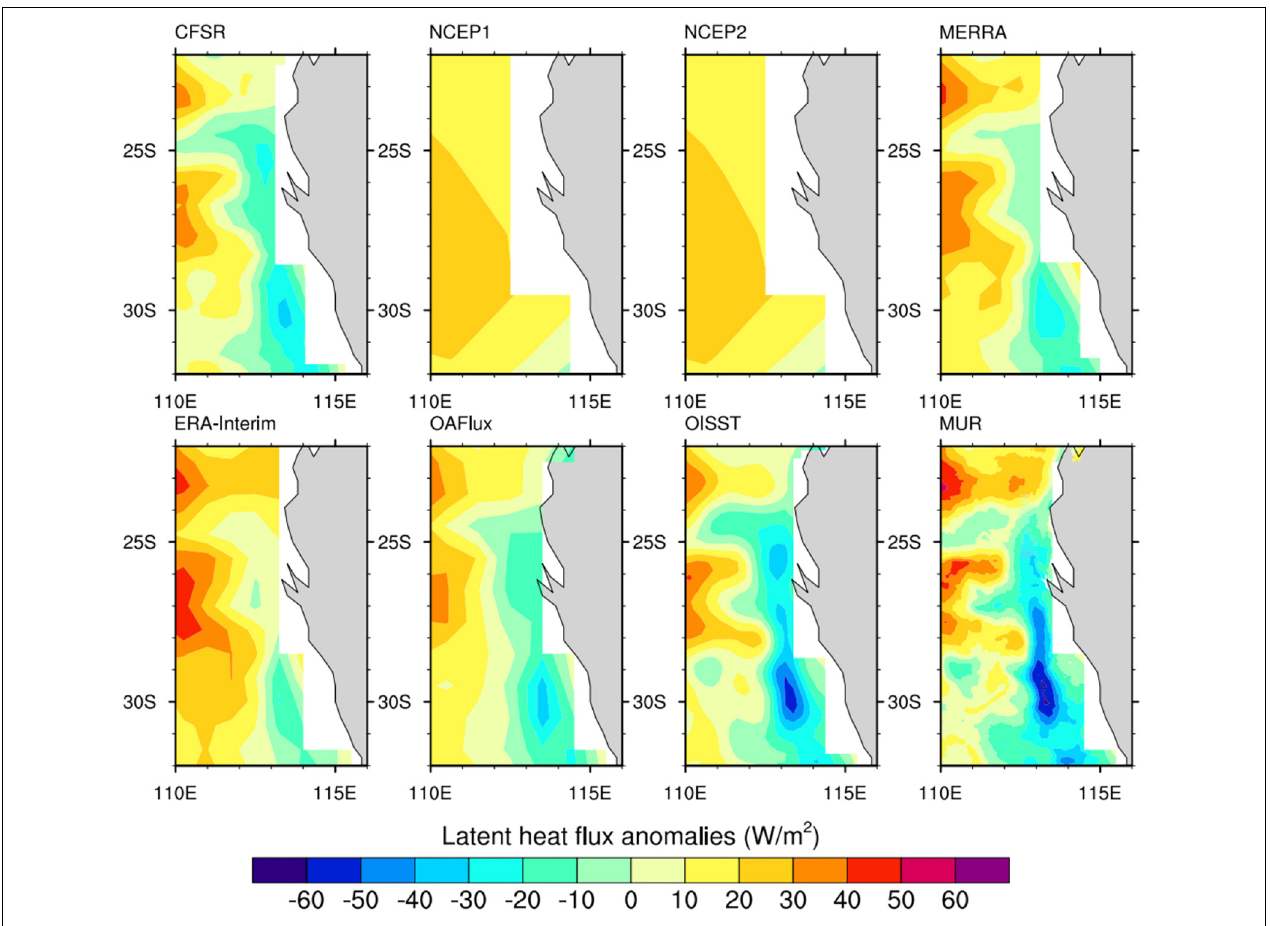
FIGURE 12 | Mean latent heat flux anomalies of January-February 2011 over the west coast of Australia from EX-sst. Positive values indicate the warming of the